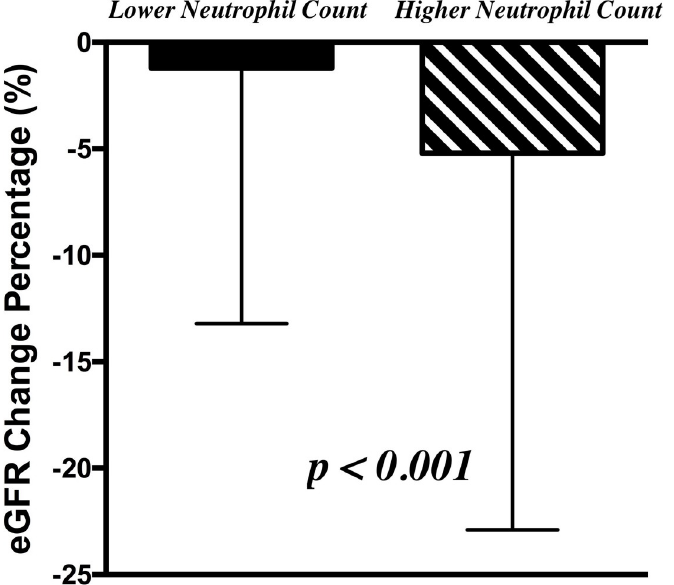
Fig 3. The renal function (presented by estimated glomerular filtration rate) change during the 2-year follow-up period between the study population with the lower and higher neutrophil count.